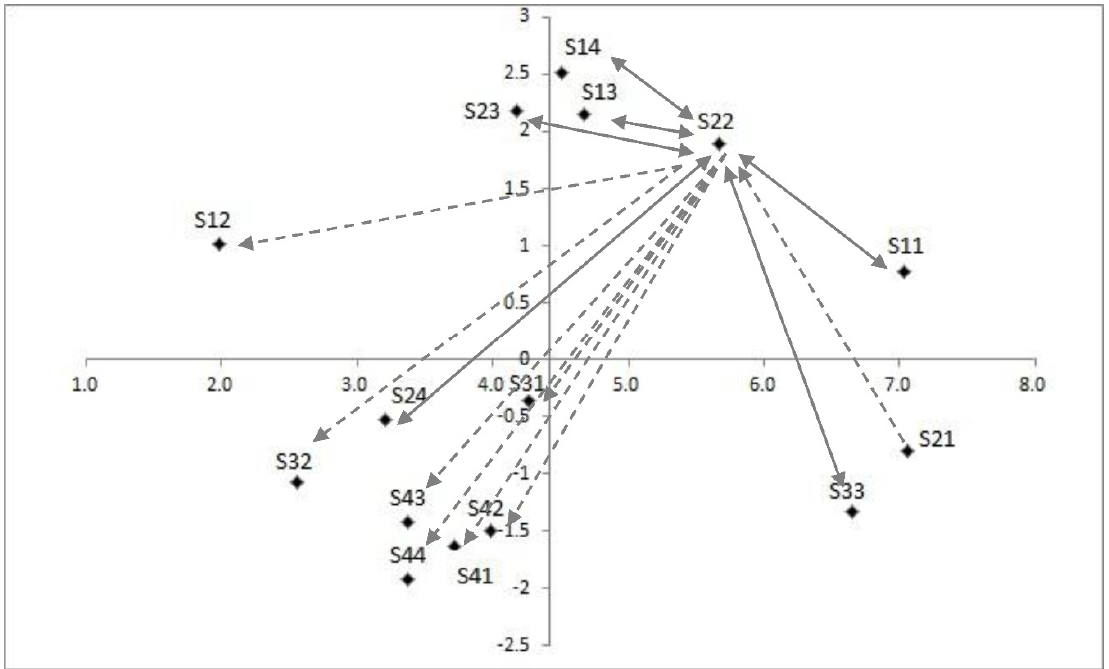
Figure A6. Casual Diagram between S22 and Other